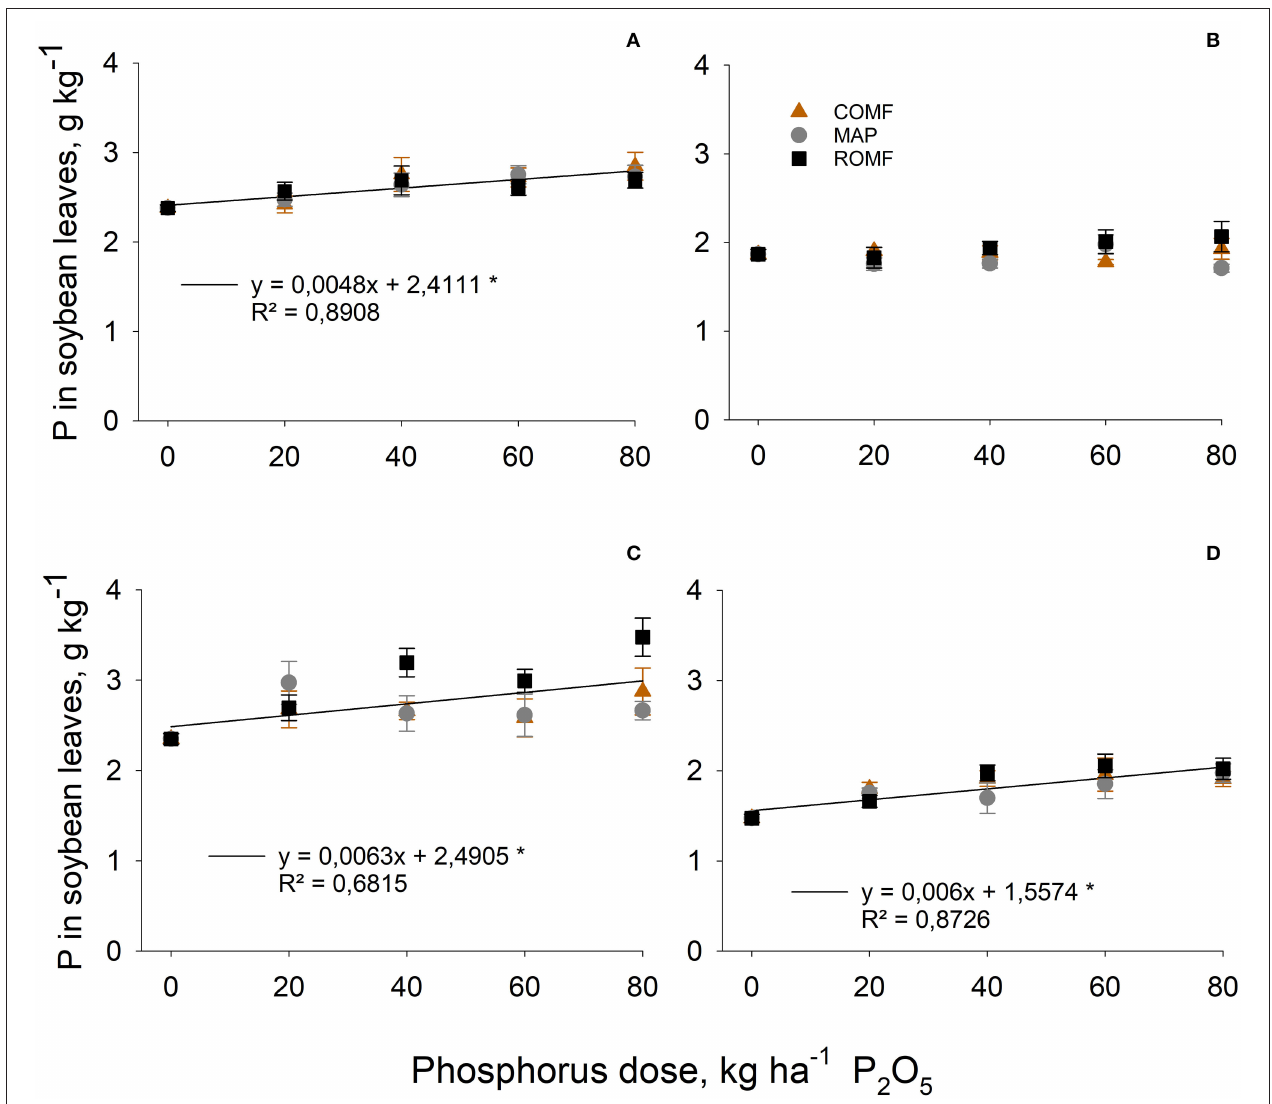
FIGURE 4 | Phosphorus content in soybean leaves with doses of fertilizer sources in the crop seasons of 2010/2011 (A) , 2011/2012 (B) , 2012/2013 (C) , and 2013/2014 (D) . COMF, composted organomineral fertilizer; MAP, monoammonium phosphate; ROMF, raw poultry litter organomineral